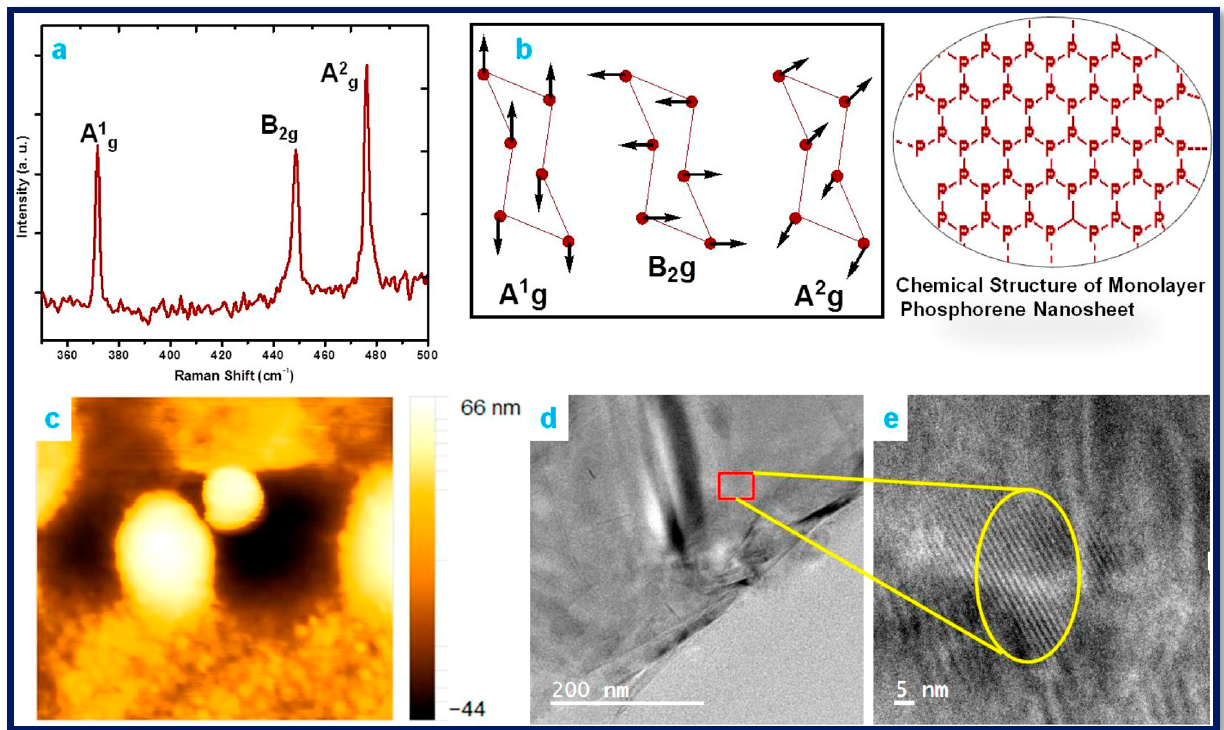
Figure 2. ( a ) Raman spectrum of BP nanosheets with ( b ) typical vibrational bands and, ( c ) surface morphology as evaluated by AFM studies, and ( d ) TEM image; ( e ) TEM image with high resolution (Scale 5 nm). On top and right-hand side, the chemical structure of monolayer of phosphorene nanosheet is depicted. Copyright 2020, the Materials Research Society Reproduced with permission from ACS Appl. Nano Mater. [42]. Copyright 2019, American Chemical Society, Washington, DC, USA.